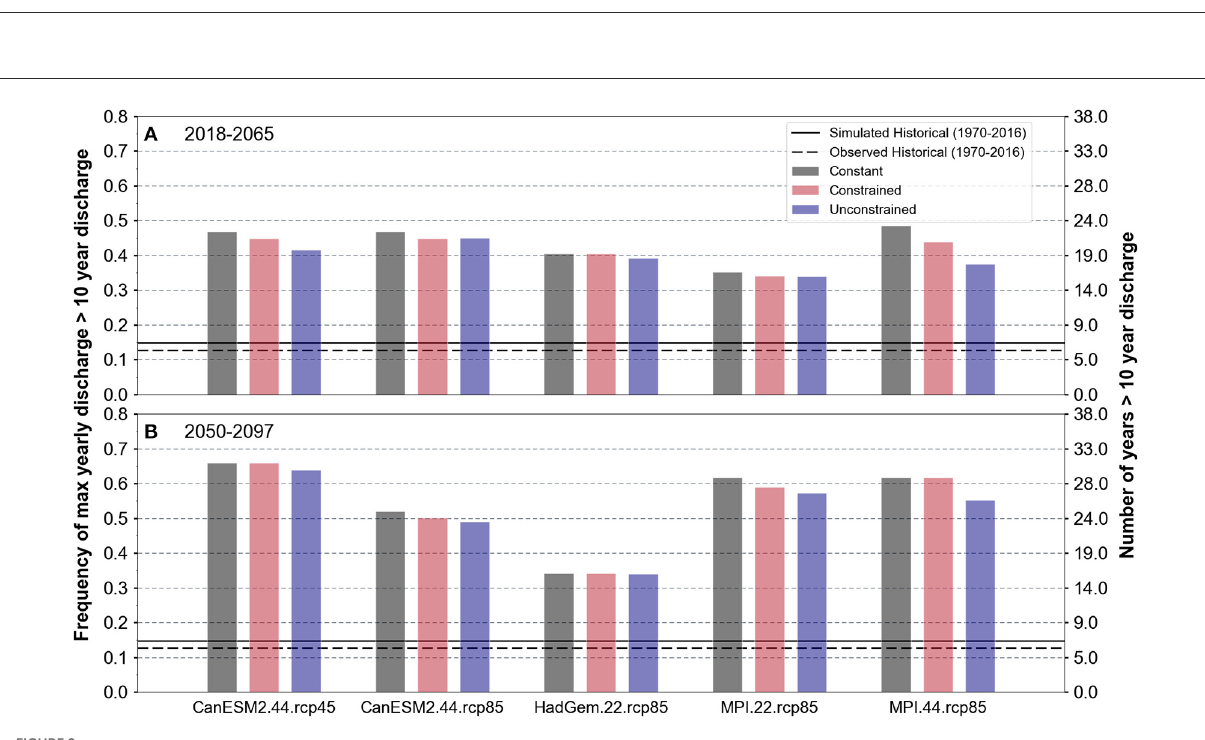
FIGURE9 Frequency of maximum annual discharge exceeding the 10-year event discharge over the 47 year simulation period for 2018–2065 (A) and 2050–2097 (B)